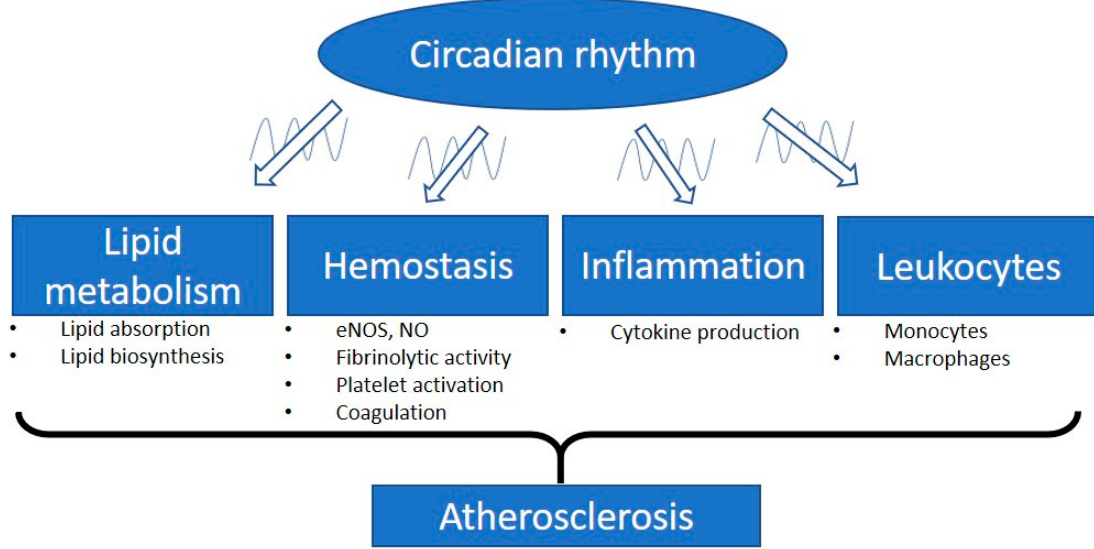
Figure 1. Involvement of the circadian rhythm in atherosclerosis. The intrinsic biological clock has an oscillation cycle of approximately 24 h. The circadian clock controls different physiological parameters of the cardiovascular system such as blood pressure, heart rate, and endothelial function. Circadian disruption is a critical factor leading to atherosclerosis and cardiovascular diseases. Plasma lipid levels are mediated by the balance of lipid absorption and biosynthesis. The lipid plasma levels display circadian oscillations and are independent of food intake. Vascular functions, especially the related endothelial nitric oxide synthase (eNOS) expression and nitric oxide (NO) production, are regulated by the peripheral circadian clock. Many of the important molecules involved in hemostasis have been shown to align with circadian rhythms, including molecules responsible for fibrinolytic activity, platelet activation, and coagulation. Dysregulation of the circadian rhythm leads to inflammation. Proinflammatory cytokines are expressed in a circadian manner. In response to inflammatory stimuli, circulating counts of leukocytes and the function of monocytes/macrophages are modulated by the circadian clock. Therefore, the misalignment of the circadian clock with these parameters could lead to the progression of atherosclerosis.